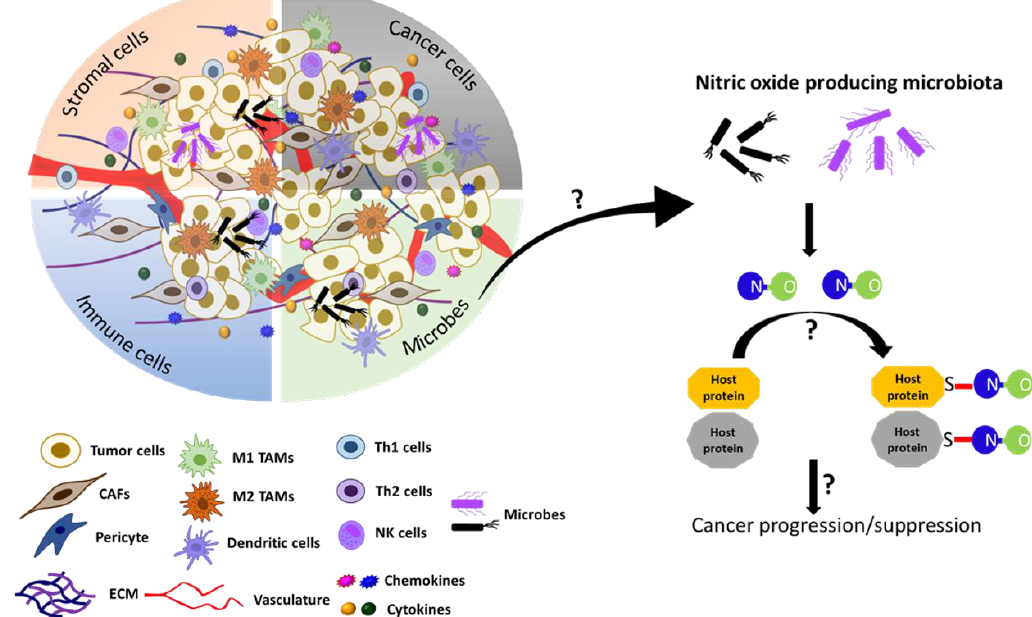
Figure 5. Model speculating the role of microbial NO in tumor progression or suppression in the tumor microenvironment. Recently, the gut microbiota in C. elegans. has been shown to produce NO and regulate the S-nitrosylation of host proteins and affect the host development [243]. The TME also contains microbes in addition to cancer cells, stromal cells, immune cells, and acellular components [238–241]. We speculate here that, if the microbiome is present in the TME, it could produce NO and regulate the tumor progression or suppression by affecting S-nitrosylation of cellular proteins in the TME.